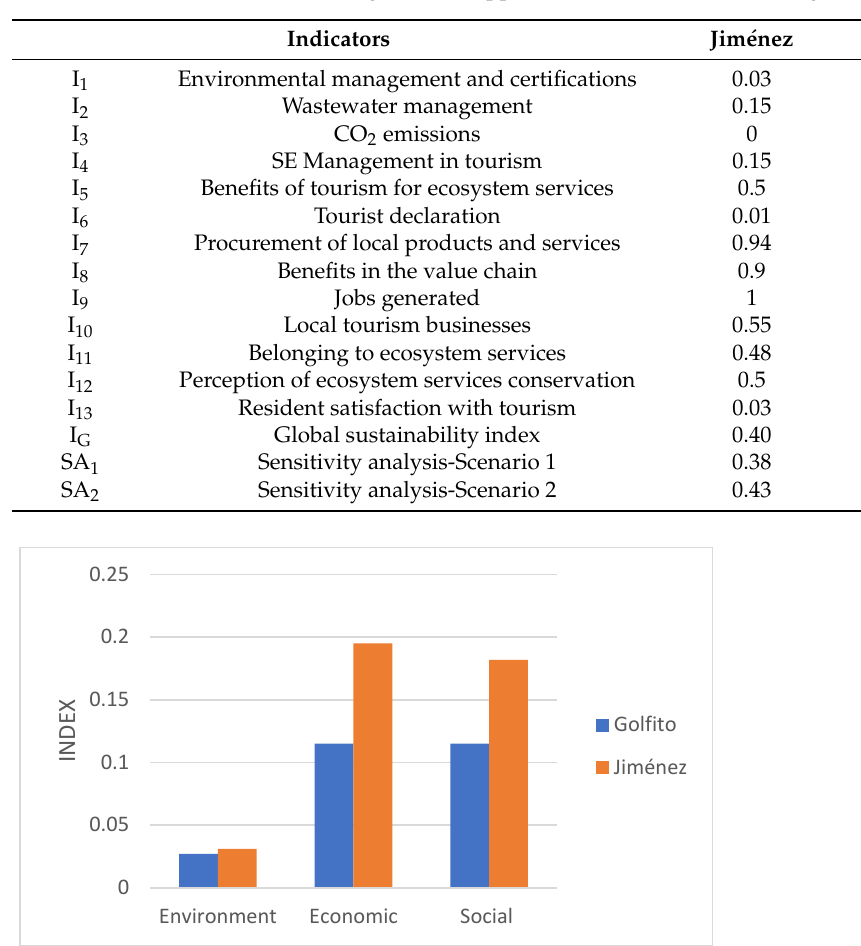
Table 5. Normalized values resulting from the application of the model according to the indicator.